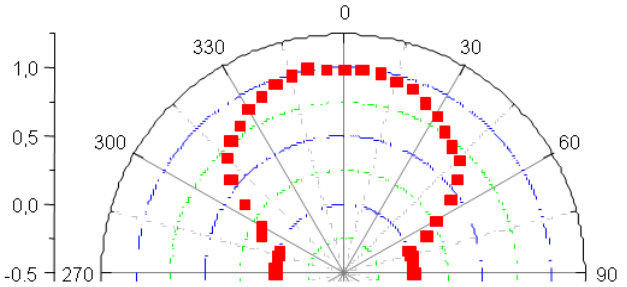
Figure 6. Reception pattern of the receiver device.